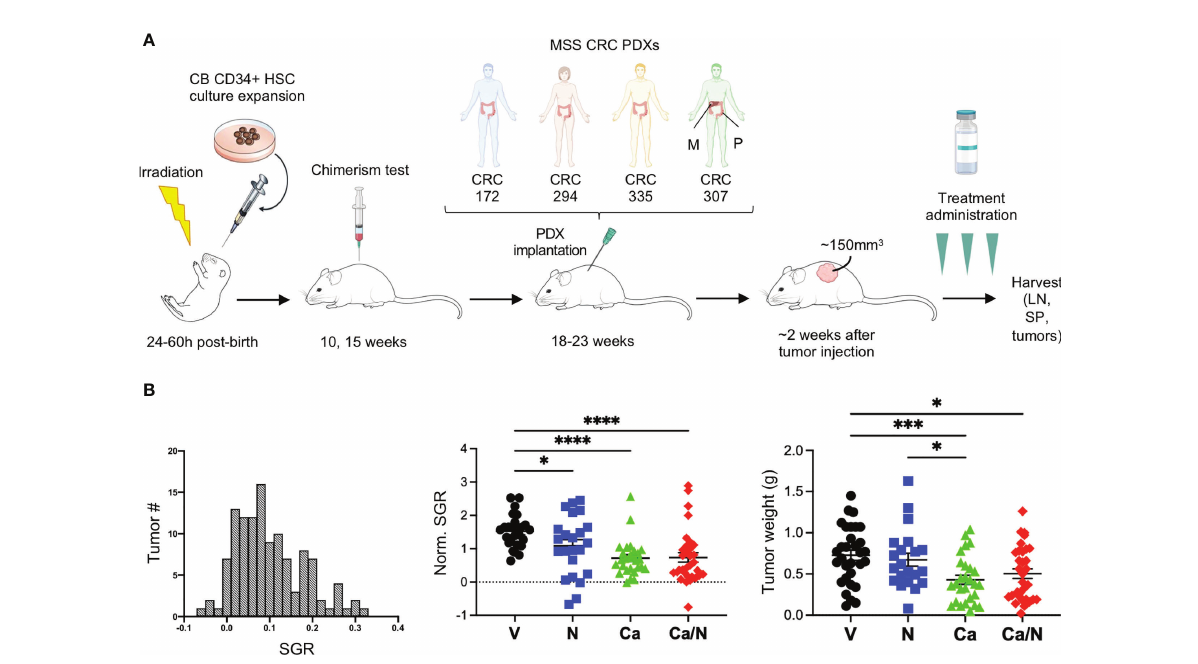
FIGURE 1 Reduced tumor growth in CRC MSS PDXs in HIS-BRGS mice treated with nivolumab, cabozantinib and their combination. (A) Experimental timeline for HIS-BRGS studies testing TKI/ICB treatments in fi ve distinct CRC MSS PDX studies. Each PDX was tested in HIS-BRGS mice generated from a unique CB. (B) The distribution of number of tumors with speci fi c growing rates (SGR) among all CRC PDX tumors in the HIS- BRGS studies (left panel); the normalized SGR among tumors in the nivolumab (N), cabozantinib (Ca) and their combination (Ca/N) treatment groups compared to untreated (V=vehicle) mice (middle panel); and CRC tumor weights at harvest in same treatment groups (right panel). P- values indicate ANOVA multiple comparisons with Welch ’ s correction: *p < 0.05, ***p < 0.001, ****p < 0.0001 or as indicated by